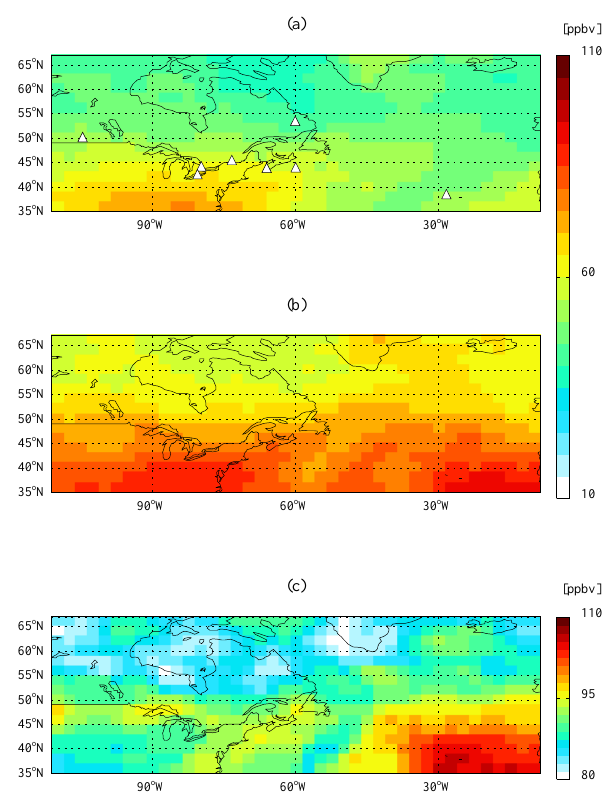
Fig. 2. Mean GEOS-Chem model ozone distribution (ppbv) across North America and the North Atlantic at (a) 750hPa (2.2km), (b) 500hPa (5.5km), and (c) 310hPa (8.9km) from 12 July to 4 August 2010. White triangles in plot (a) show the location of ozonesonde launch sites used during the BORTAS-A campaign across Canada, listed in Table 1, and the Pico Mountain Observatory in the mid-